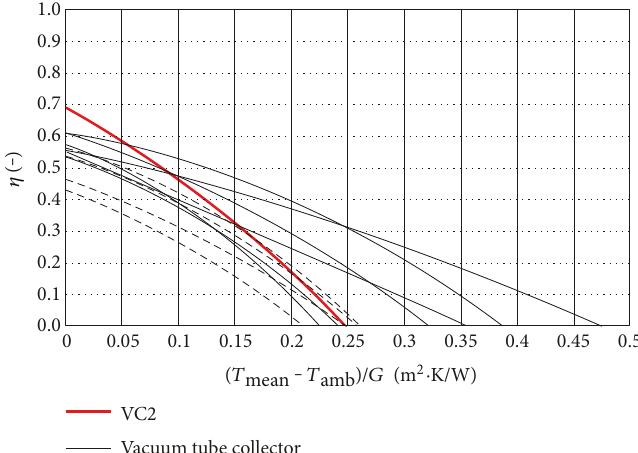
Figure 9: E ffi ciency characteristics of fl at plate collector variant VC2 and vacuum tube Table 3: Calculated annual solar collector gain with respect to the collector gross area.